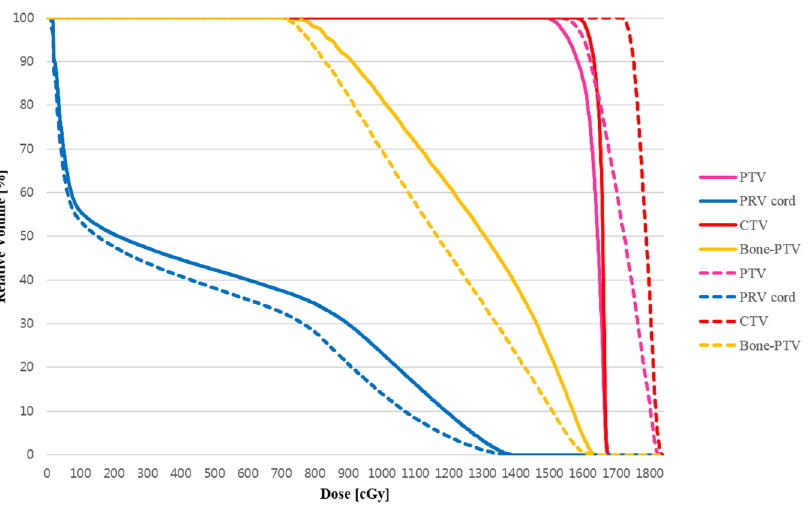
Fig 4. Dose volume histogram for the planning target volume (PTV) and organs at risk (OAR) from 3D printed spine phantom sets (solid line for digital light projection (DLP) printed phantom, and dotted line for Polyjet printed phantom) from spine stereotactic body radiation therapy (SBRT) treatment